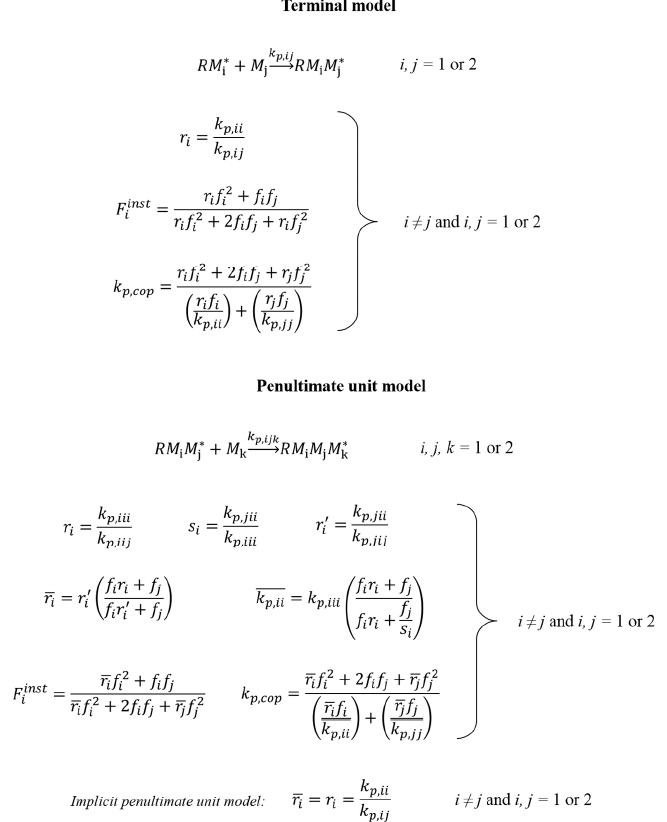
Figure 2. Definition of reactivity ratios and fundamental equations of the terminal and the penultimate unit models of copolymerization for a binary system. RM i* , radical with terminal monomer unit of type i ; M , monomer of type j ; k , propagation rate coefficient; j r , monomer reactivity ratio; F , instantaneous copolymer composition; f , composition of the M j* , radical with terminal monomer unit of type j and penultimate unit monomer phase; RM i of type i ; s , radical reactivity